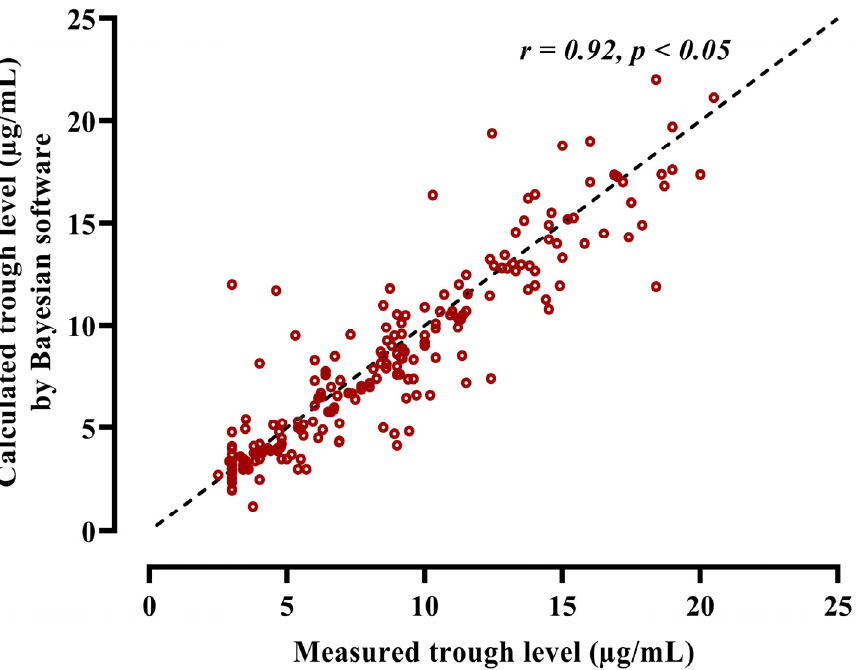
Figure 2. Diagnostic goodness of fit between measured and calculated vancomycin trough levels.